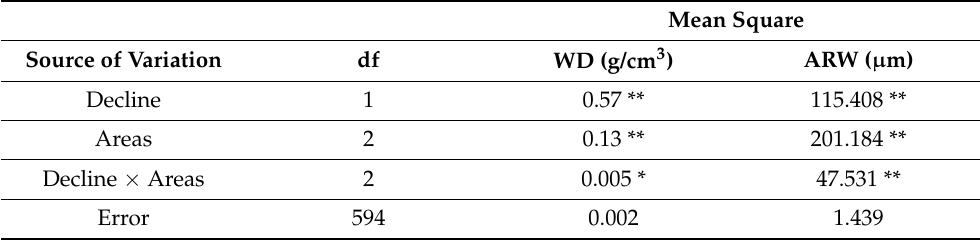
Table 3. Summary of Student’s t -test analyses of differences in wood characteristics (means ± SE) between healthy and declined Quercus brantii affected by drought stress.